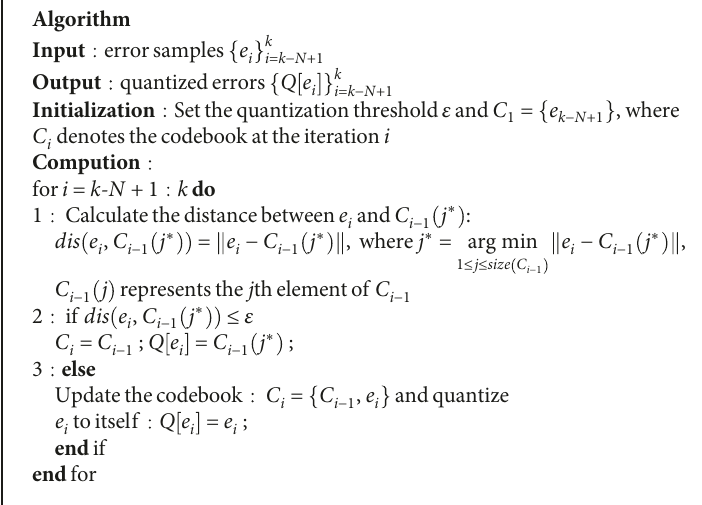
Algorithm 1: Pseudocode of estimating IP Q